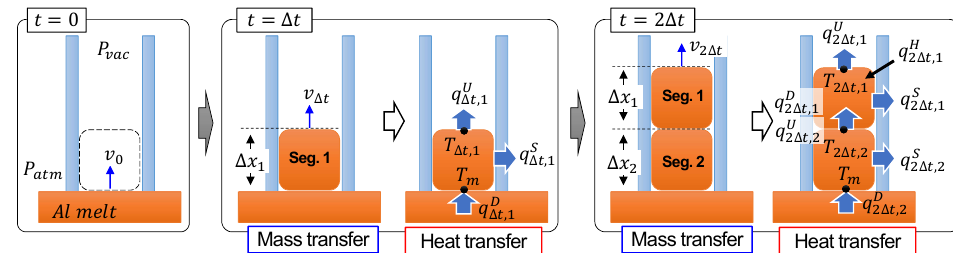
Figure 3. Schematic diagram of the calculation process of the present fluidity